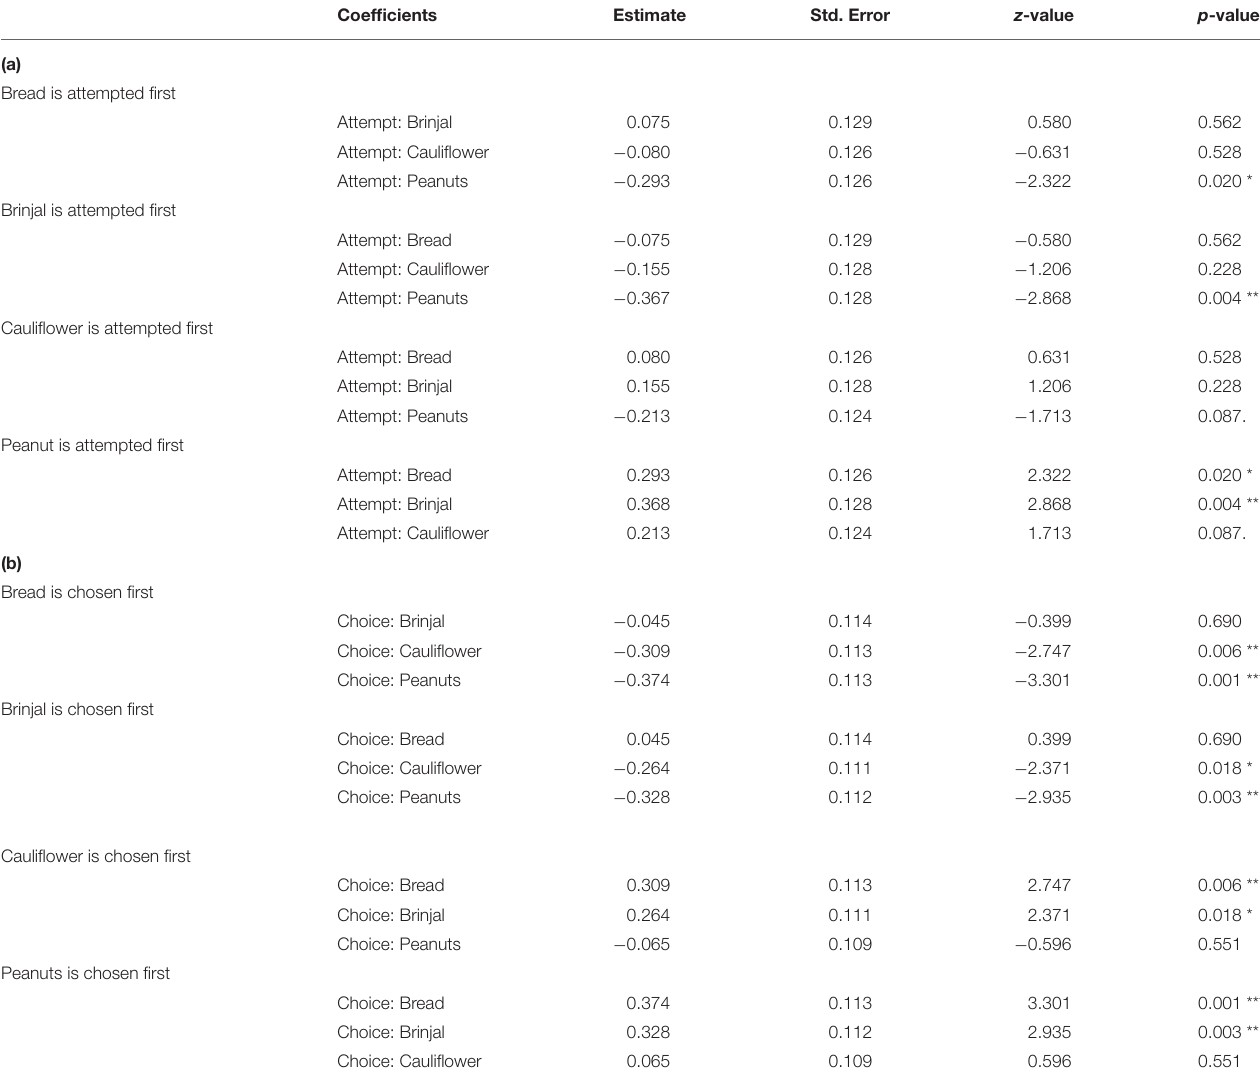
TABLE 1 | Table representing the estimates, and p -values of the multinomial logit models, set 1 and 2, respectively for (a) attempt, and (b) choice probabilities. Coefficients Estimate Std. Error z